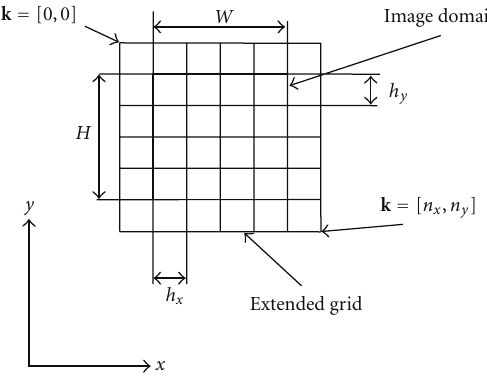
Figure 3: Formation of grid of control points for B-spline intensity transform.